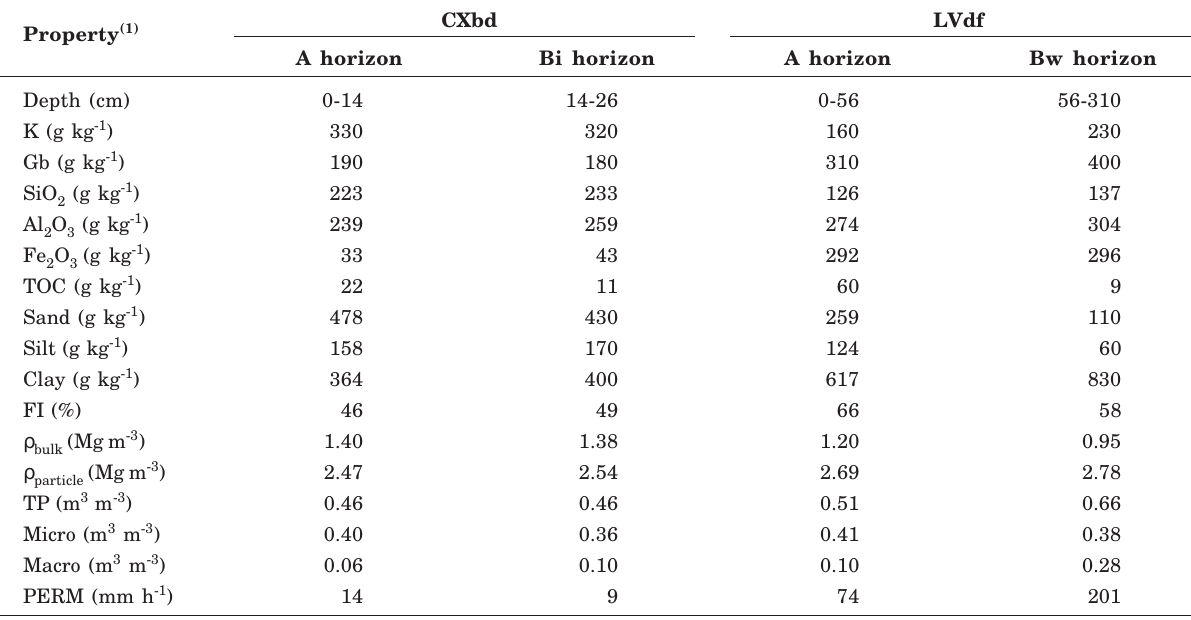
Table 1. Chemical, physical and morphological properties of a typic dystrophic Tb Haplic Cambisol (CXbd) and a typic dystrofic Red Latosol (LVdf)